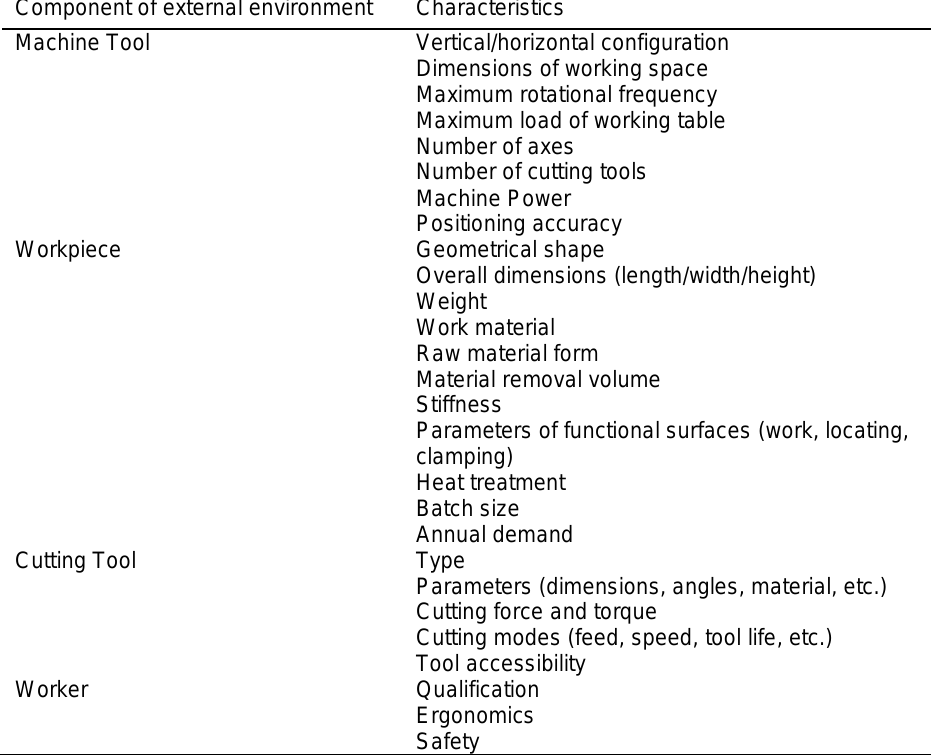
Table 1. The relationship of fixture with the external